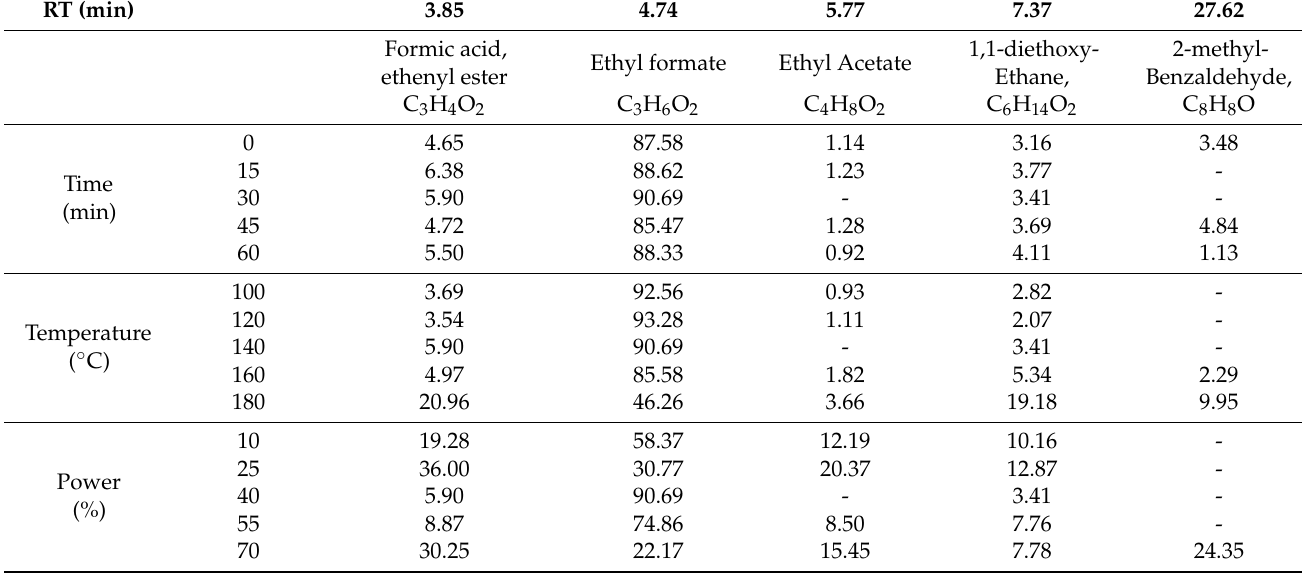
Table 3. GC-MS composition analysis of ultrasonic ethanol-treated liquid